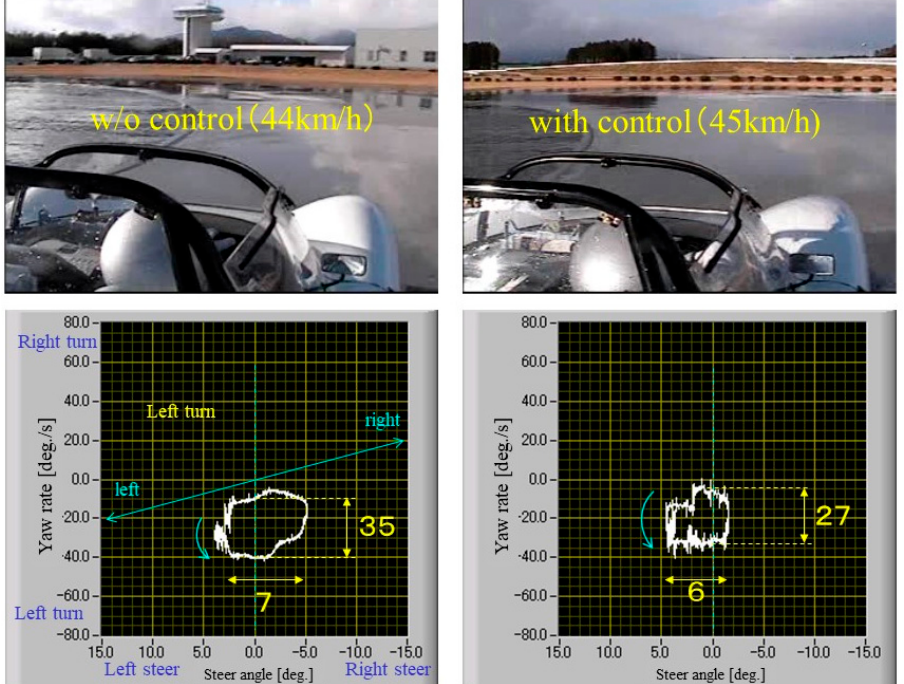
Figure 9. Steering maneuvering on the wet skid pad compared between vehicles with and without the tire digital control. More details can be found in Supplementary Materials (Video S1: without control and Video S2: with control).